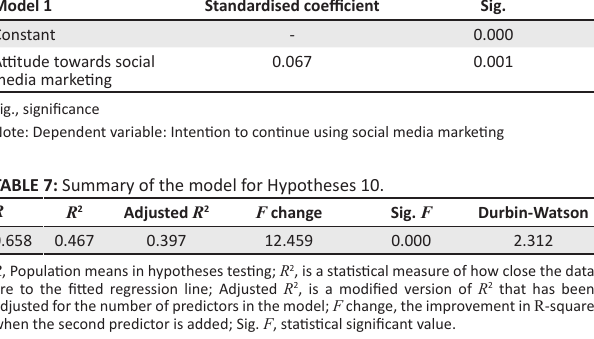
TABLE 6: Regression extracts for hypothesis 10. Model 1